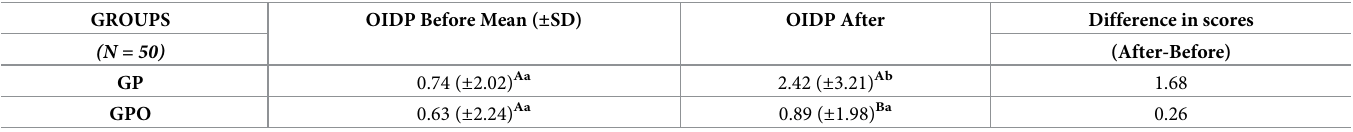
Table 2. OIDP evaluating the sensitivity with the patients’ quality of life before and after the bleaching treatment. GROUPS OIDP Before Mean ( ± SD) OIDP After Difference in scores (N = 50) (After-Before) GP 0.74 ( ± 2.02) Aa 2.42 ( ± 3.21) Ab 1.68 GPO 0.63 ( ± 2.24) Aa 0.89 ( ± 1.98) Ba 0.26 � Different capital letters represent a statistically significant intergroup difference, according to the Wilcoxon Test (p � 0.05); � Different capital letters represent statistically significant intergroup difference (p � 0.05); �� Different lowercase letters represent statistically significant intragroup difference (p �